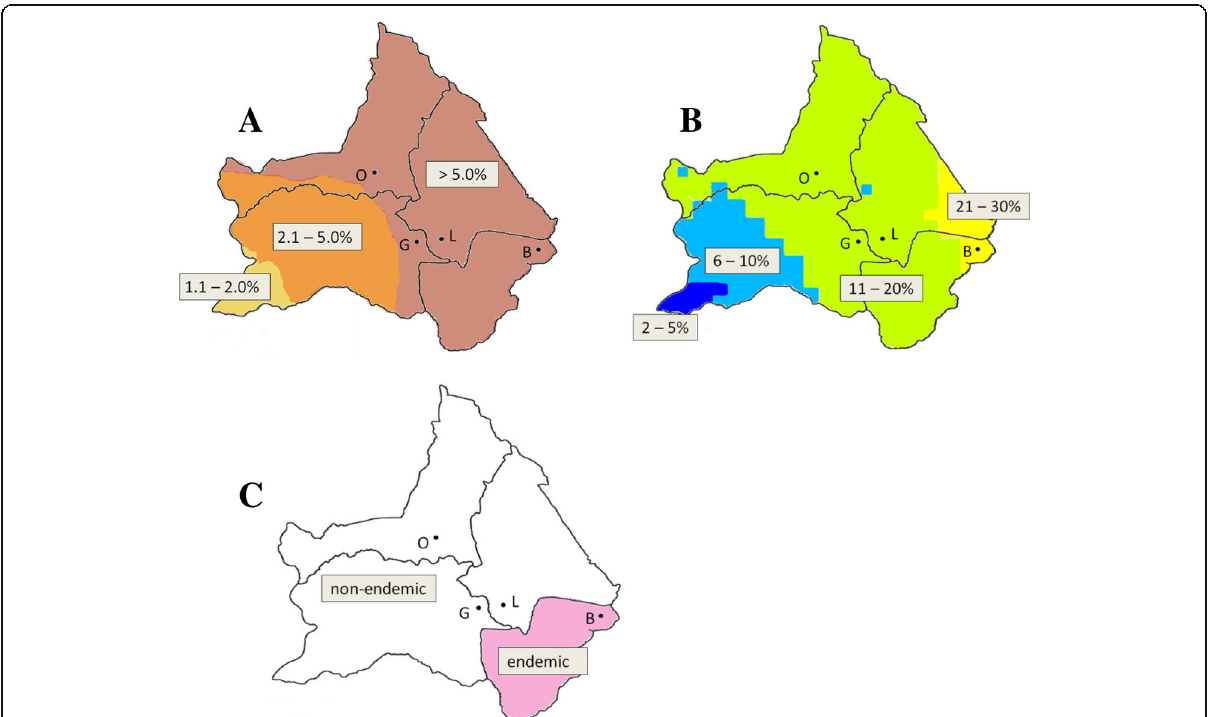
Fig. 3 Three published maps showing prevalence or endemicity of bancroftian filariasis in Uganda. Our four study sites are plotted on each map. O Oloyotong, G Goro, L Labworomor, B Barromo. a The map reported by Onapa et al. [8]. All of our four study sites are in the >5.0% endemic zone. b The map is from Global Atlas of Helminth Infections (GAHI). The original map is reported by Moraga et al. [16]. Three of our sites are in the 11 – 20% prevalence zone, and one in the 21 – 30% zone. c The map is reported by Kolaczinski et al. [17]. Three of our sites are in the districts classified as non- endemic, and one in the endemic